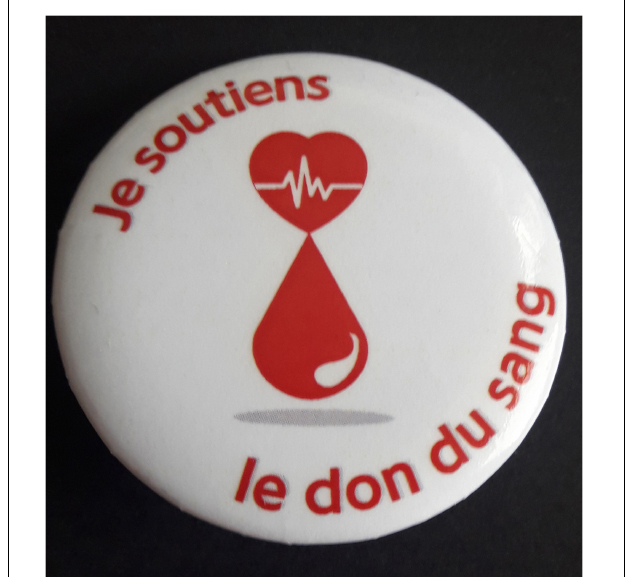
FIGURE 1 | Badge used in the initial act of support condition in Study 1. The text is in French and means “I support blood donation.” Designed by the studio Atelier du Badge, using a logo taken from freepik.com. The badge size is 37